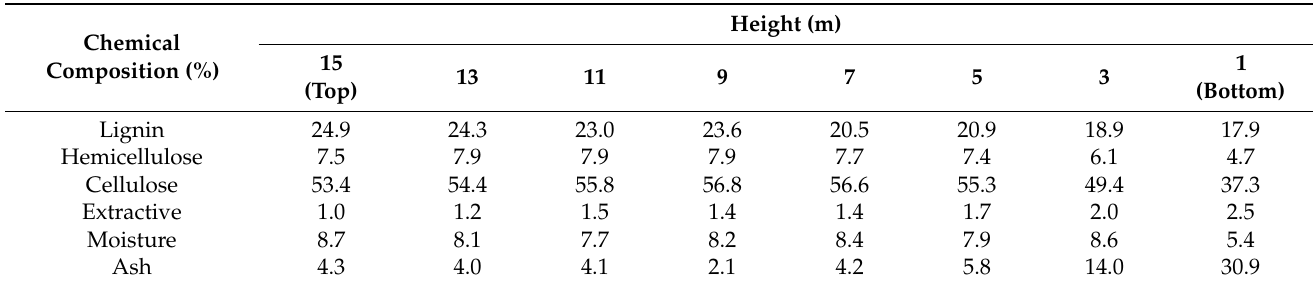
Table 4. Chemical composition of SPF obtained from various heights of the tree. Data are adapted from Ref. [53]. Copyright